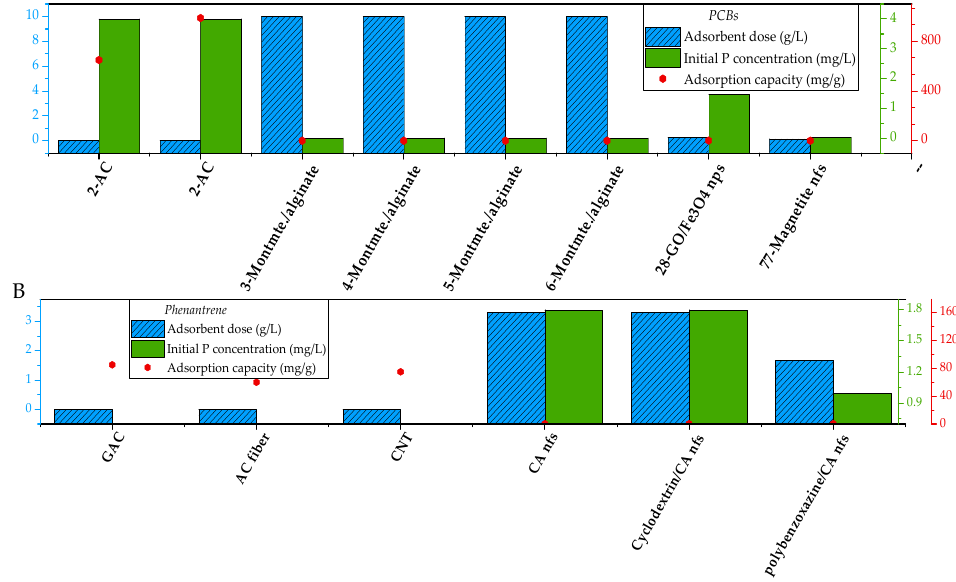
Figure 11. Graphs showing the proportion between adsorbent dose (blue column, left scale), initial pesticide concentration (green column, middle right scale) and adsorption capacity (red scatter, far left scale) in the adsorption of PCBs ( A ) and Phenantrene ( B ). Activated carbons and carbon nanotubes however, demonstrated an adsorption capacity of 85 mg/g for a dose of 4 mg/L (initial concentration was not reported) (Table 20, N 7). It can be suggested that π – π electron interaction between the unsaturated Phenantrene aromatics and the carbon adsorbent surface is the predominant reaction mechanism; in that sense, a higher carbon content and full crystalline structure would lead to an increased specific surface area and, for a large pore volume of adapted size, Phenantrene adsorption. Among the reported carbon-based materials, granular activated carbon possessed a BET of 706 m 2 /g and a pore volume of 0.711 cm 3 /g, yielding the highest performance. On the other hand, carbon nanotubes with a higher pore volume of 0.818 cm 3 /g but a lower BET of 537 m 2 /g showed a capacity of 75 mg/g (Table 20, N 4). Furthermore, activated carbon fibers with the highest BET of 949 m 2 /g but the lowest pore volume of 0.381 cm 3 /g yielded a lower capacity of 60 mg/g (Table 20, N 6), indicating a synergetic effect of pore volume and surface area (BET).